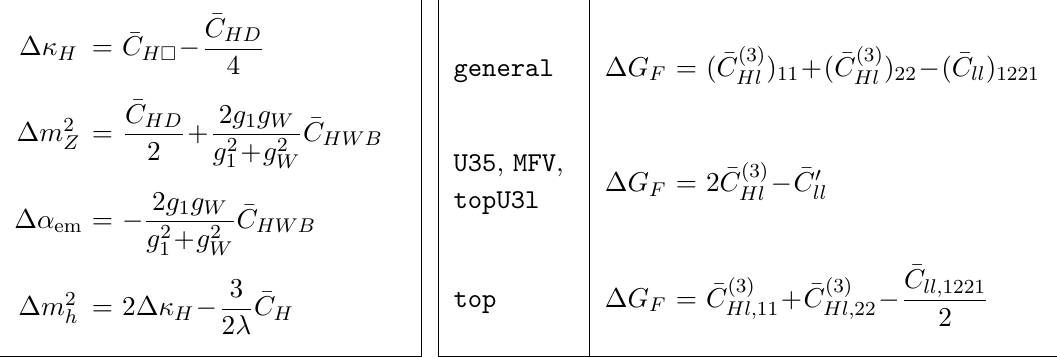
varies F = C (ˆ v 2 / Λ 2 ) . α α